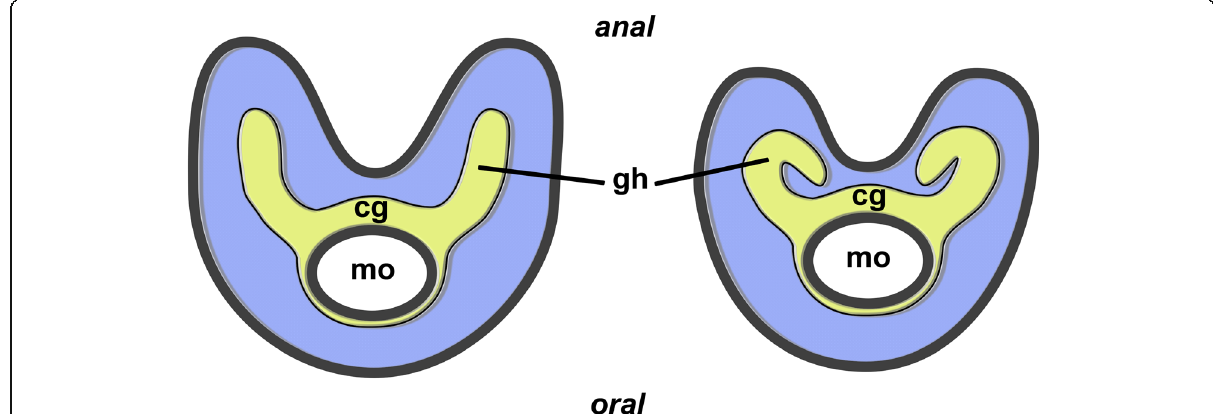
Fig. 17 Schematic drawing of the neuronal structures of the lophophoral base of most phylactolaemates (left) and Stephanella hina (right).